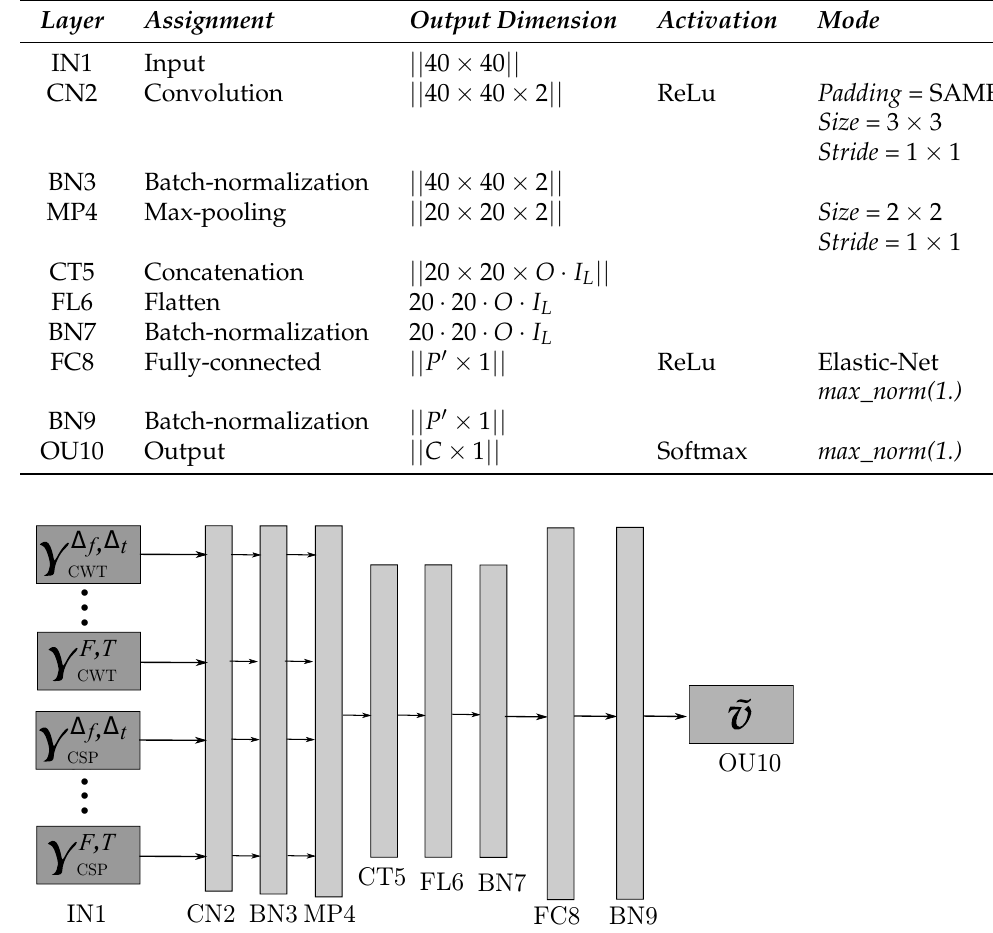
Table 1. Detailed Deep and Wide architecture of transfer learning. Layer FC8 accomplishes the regularization procedure using the Elastic-Net configuration, while layers FC8 and OU10 apply a kernel constraint adjusted to max_norm(1.) . Notation O = RN ∆ N τ , N ∆ denotes the number of filter banks, P (cid:48) —the number of hidden units (neurons), C —the number of classes, and I L stands for the amount of kernel filters at layer L . Notation stands for the concatenation operator. || · ||